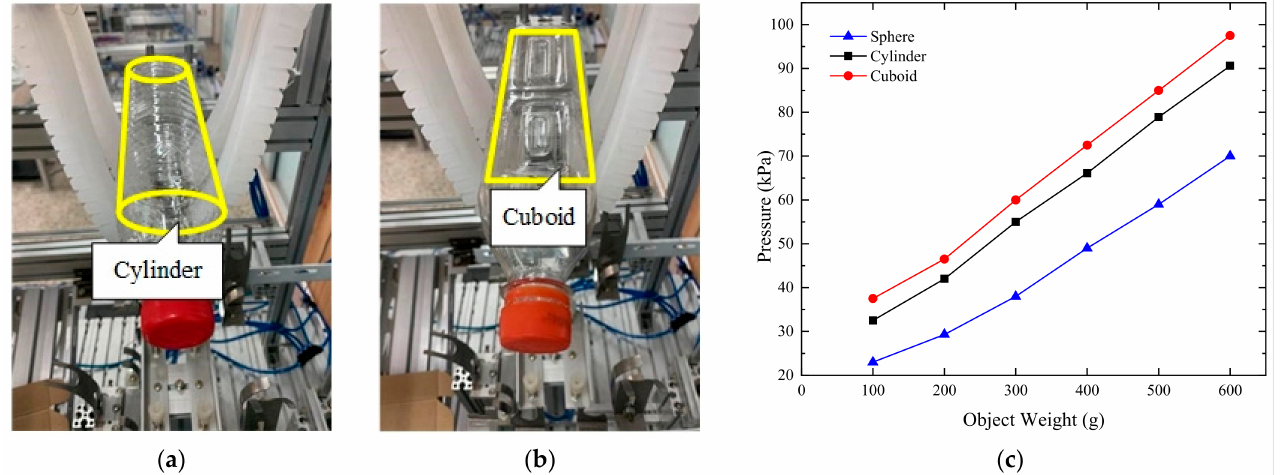
Figure 16. The four-finger soft manipulator grasps different shape containers: ( a ) cuboid; ( b ) cylinder; ( c ) performance of four-finger soft manipulator under different